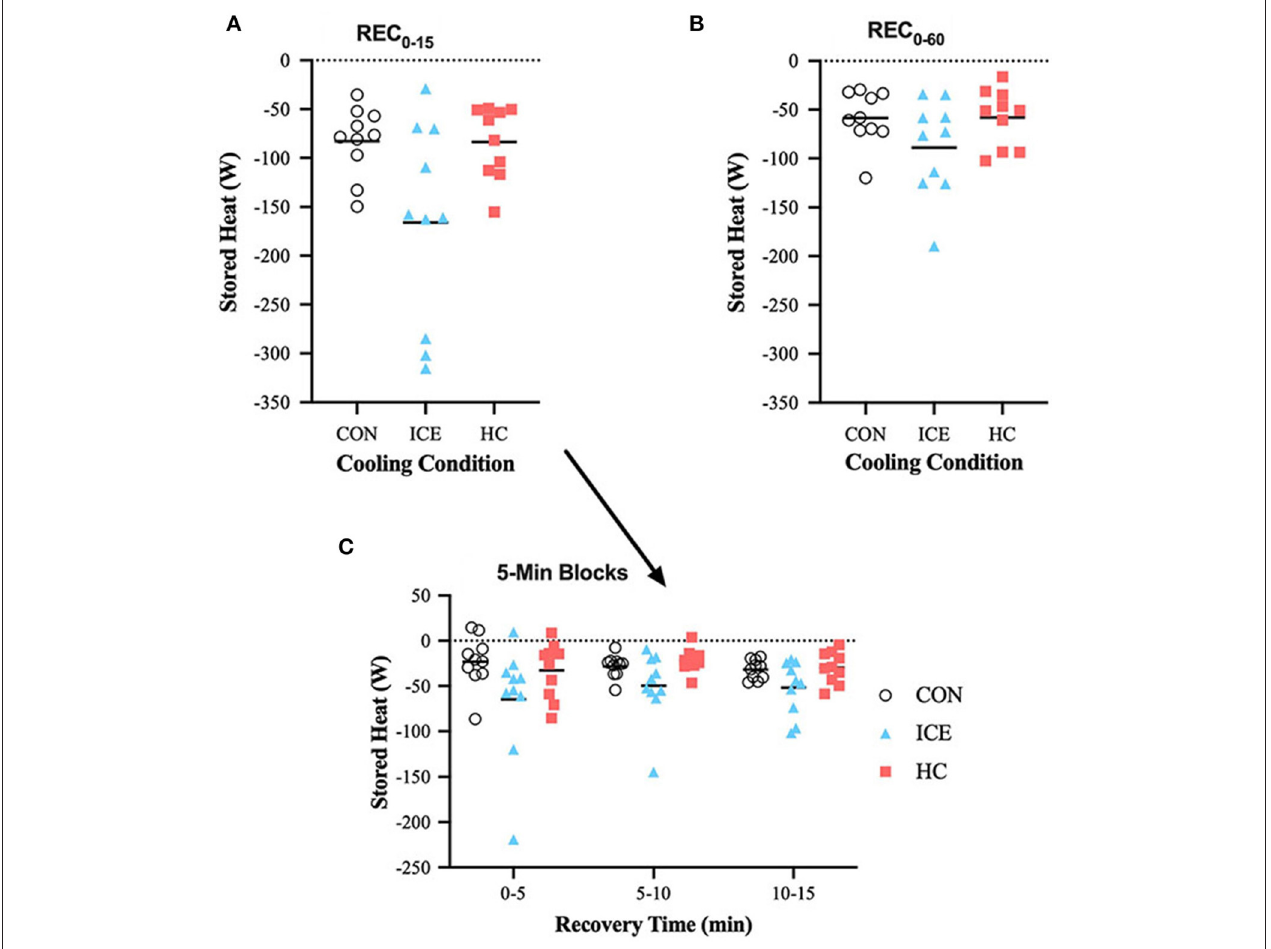
FIGURE 1 | Mean (bar) and individual delta stored heat ( S ) during REC 0 − 15 (A), REC 0 − 60 (B), and 5-min blocks during REC 0 − 15 (C) when using ice vest (ICE), single-hand cooling (HC), and non-cooled control (CON) during heated exercise recovery.